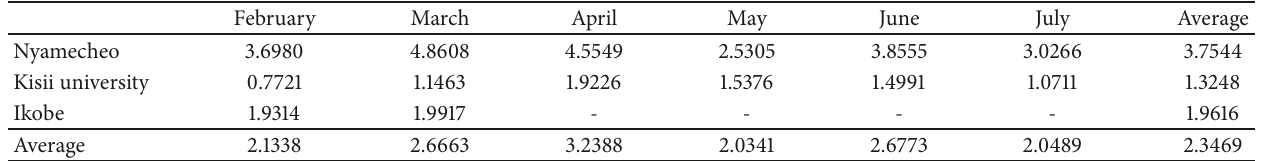
Table 3: Average roughness parameter